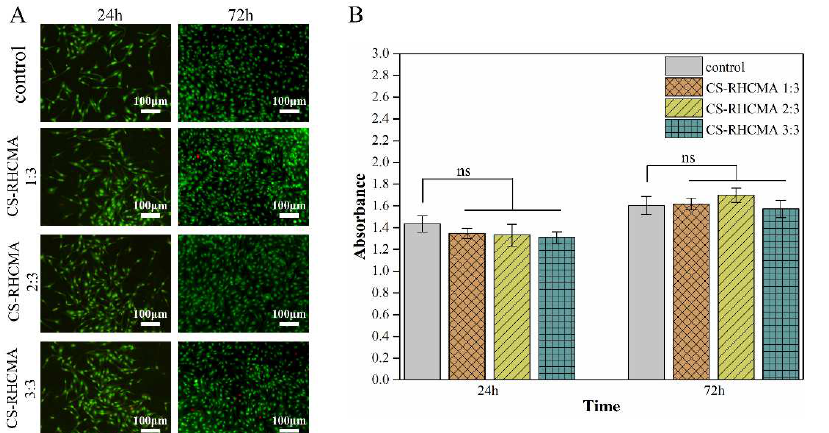
Figure 6. Cytotoxicity test of the CS-RHCMA bioinks. ( A ) Cellular morphology from the elution test was analyzed by AO/EB double-fluorescent staining after 24 and 72 h (living cells showing bright green, dead cells showing red). Scale bar = 100 μm. ( B ) Viability of HUVECs cultured in sample extracts assessed by CCK-8 assay at 24 and 72 h. None significant (ns) indicates p > 0.05.